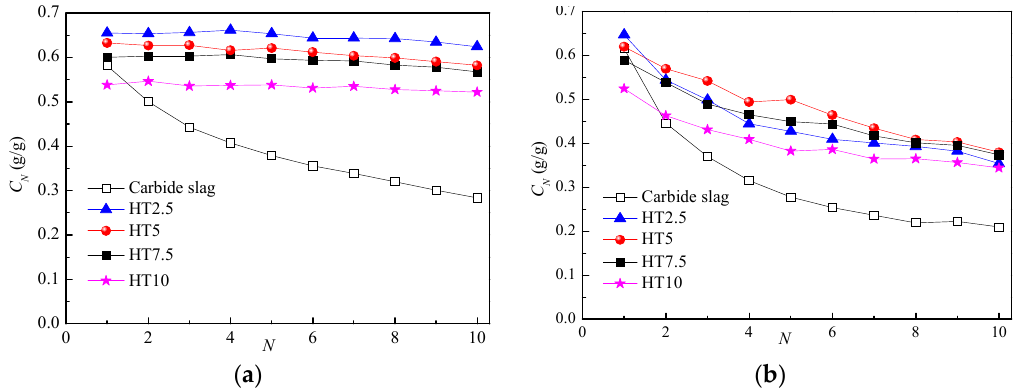
Figure 5. CO 2 capture capacities of synthetic sorbents prepared using hydrothermal template method under the ( a ) mild and ( b ) harsh calcination conditions (carbonation in 15% CO 2 /N 2 at 700 °C for 20 min, calcination (mild) in 100% N 2 at 850 °C or (harsh) in 70% CO 2 /N 2 at 920 °C for 10 min).